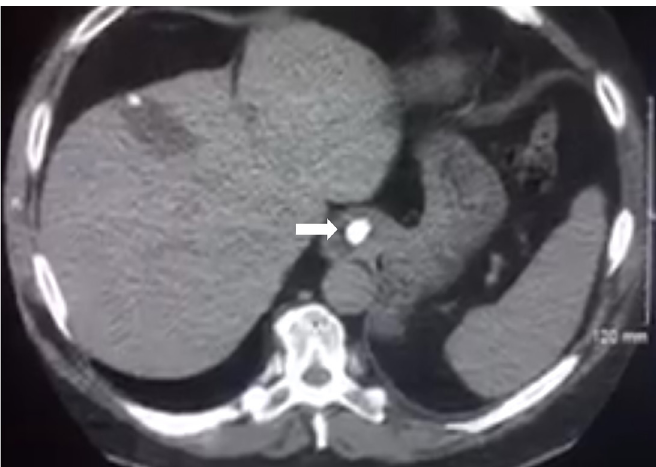
Image 2. Image of this patient’s computed tomography with the foreign body located near the gastroesophageal junction